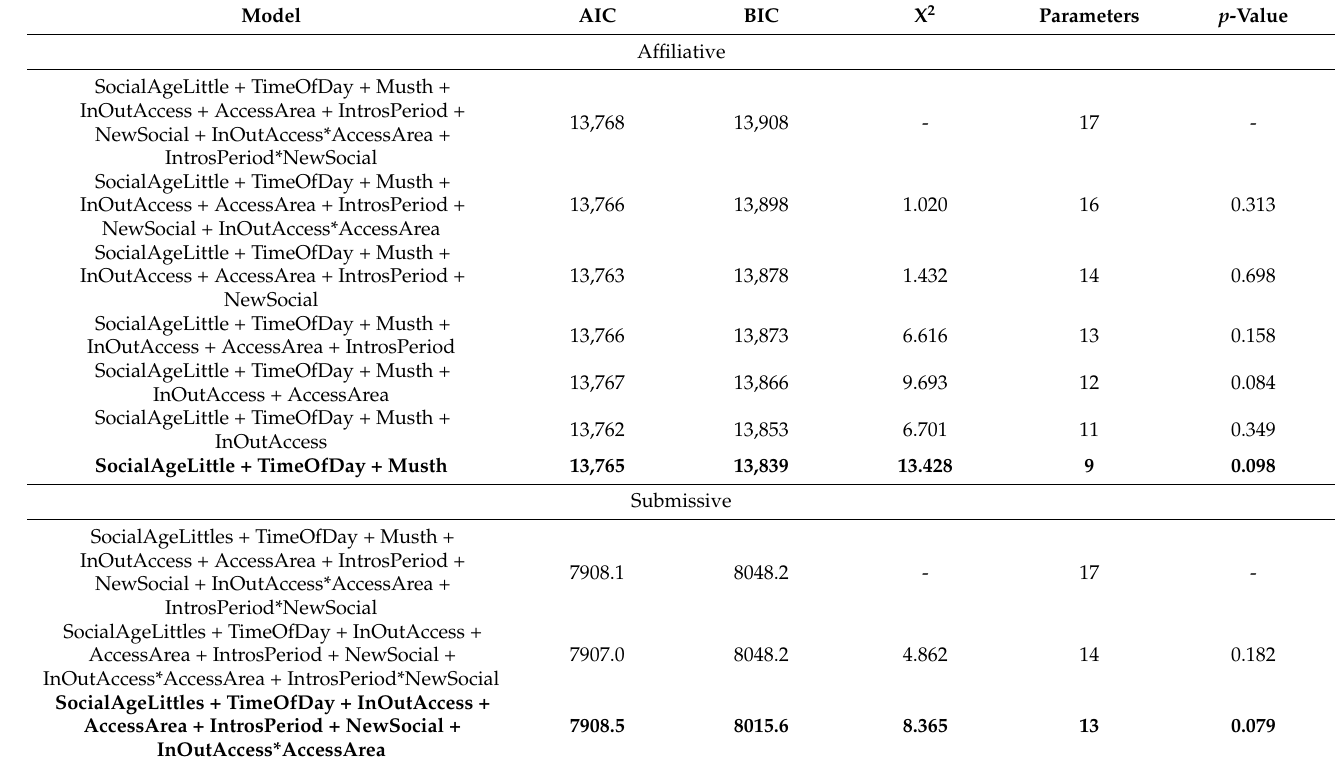
Table A1. Model selection table for GLMER of adolescent behaviors (adolescent focal data; bold indicates the final model selection). p -value from comparison to full model with